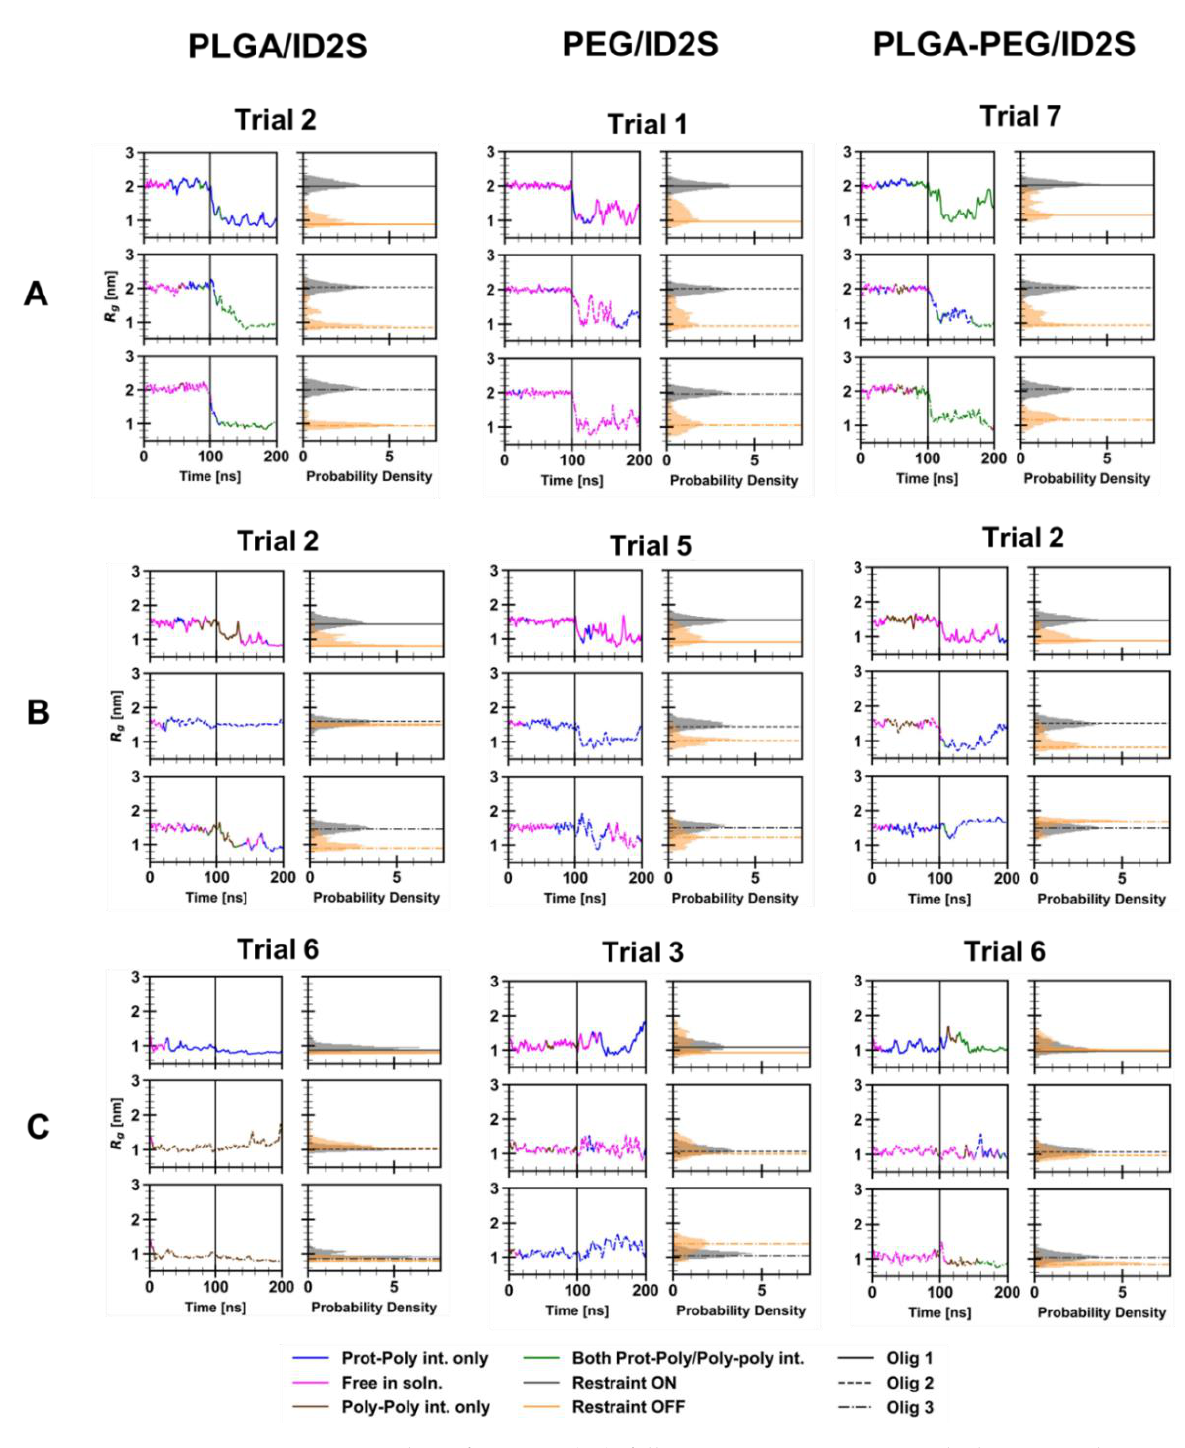
Figure 4. Radius of gyration (R g ), following a moving average calculation to reduce noise, was plotted against simulation time for each oligomer for the selected trials, in addition to the probability density of R g in both restraint-ON and -OFF phases. ( A ) indicates high extension, ( B ) medium extension, and ( C ) low extension for PLGA/ID2S ( left ), PEG/ID2S ( middle ), and PLGA-PEG/ID2S ( right ) systems. The four interaction classes were overlaid on the R g vs. time data to understand the overall behavior of protein–polymer binding.